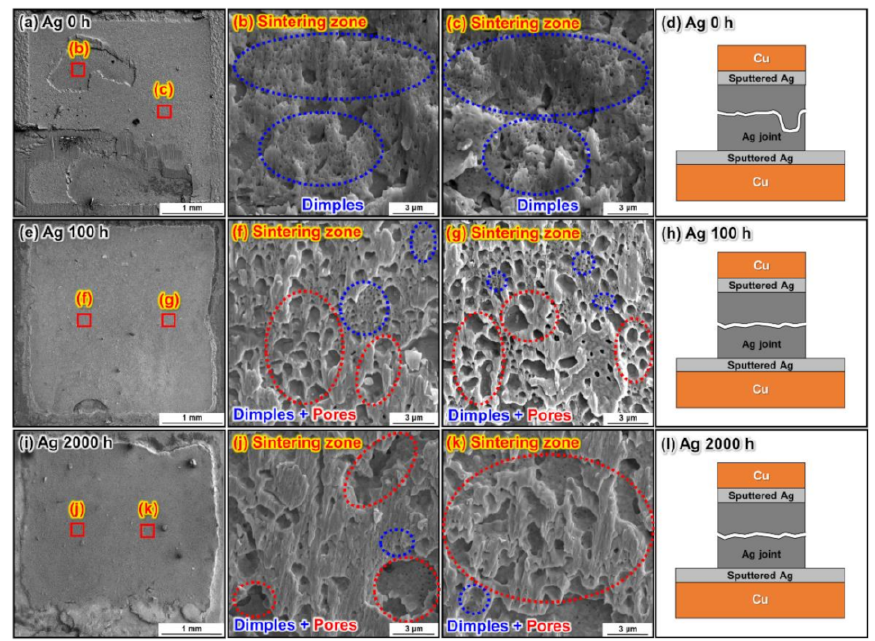
Figure 13. Surface fracture analysis of the sintered Ag joints bonded at 10 MPa. Fracture planes of the sintered Ag joints ( a ) as-bonded and after ( e ) 100 h and ( i ) 2000 h of HTS at 300 ◦ C. ( b , c ), ( f , g ), and ( j , k ) are magnified images of the fracture plane areas marked in ( a , e ), and ( i ), respectively. Schematic of the crack propagation in the sintered Ag joints ( d ) as-bonded and after ( h ) 100 h and ( l ) 2000 h of HTS at 300 ◦